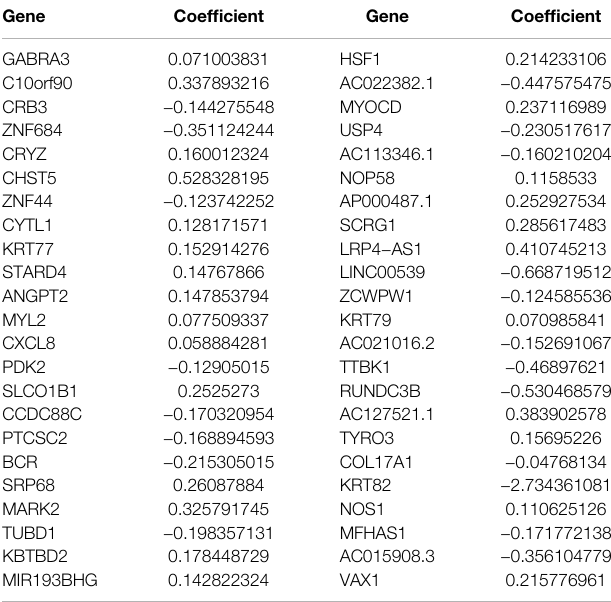
TABLE 1 | The regression coef fi cient of 46 genes in the 46-gene prognostic model. Gene Coef fi cient Gene Coef fi cient